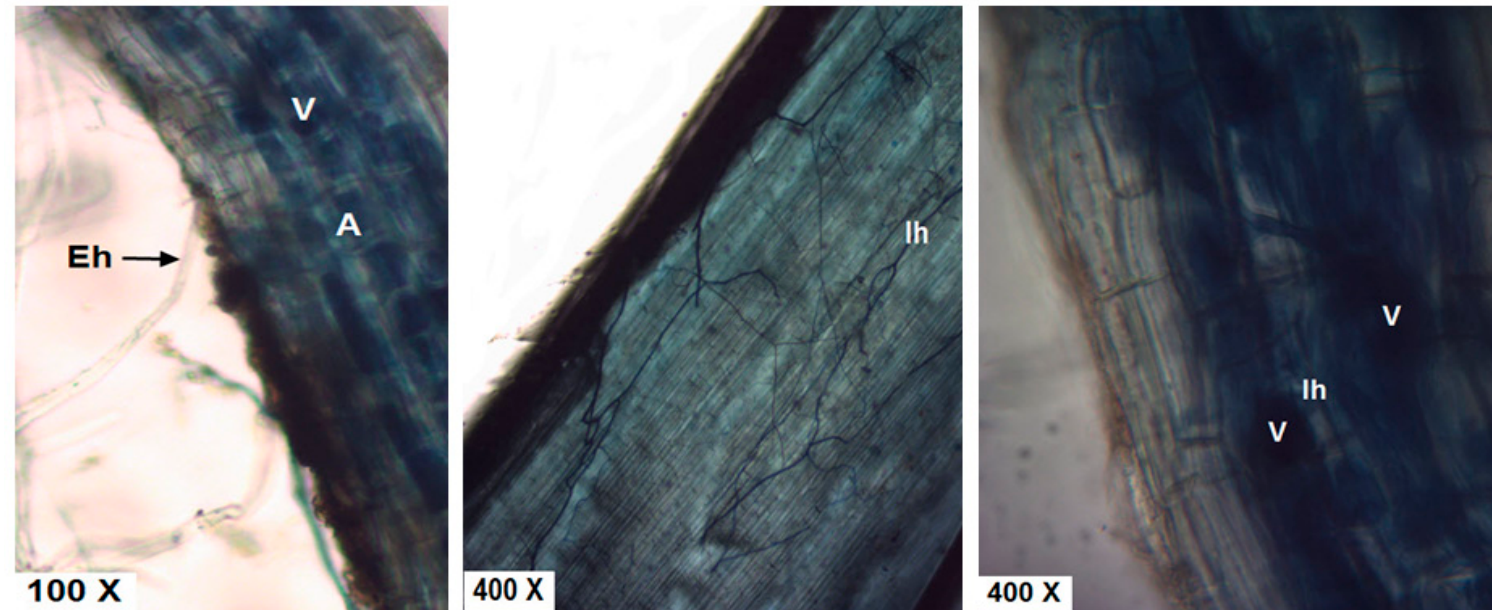
Figure 5. Root segment of maize root colonized with arbuscular mycorrhizal fungi showing the structure of fungal tissue. Where, Eh = external hyphae, Ih = internal hyphae, V = vesicle, and A = arbuscule.